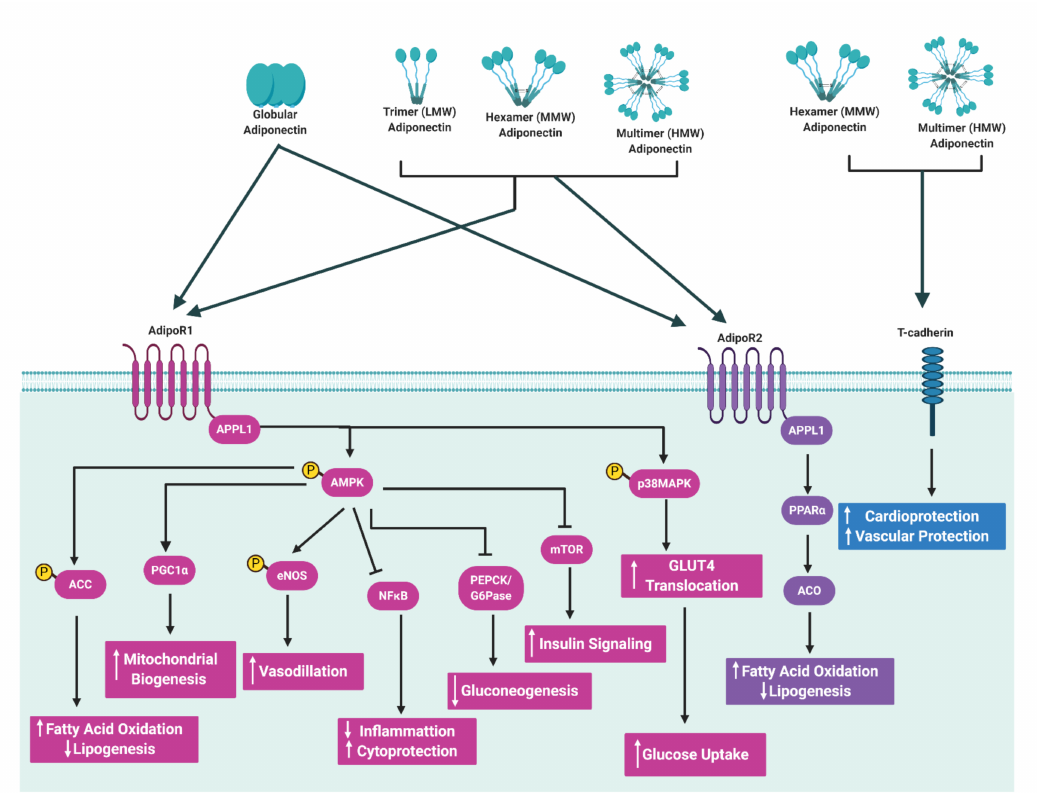
Figure 3. Schematic illustration of adiponectin intracellular signaling pathways. Adiponectin binds to its receptors (AdipoR1 and AdipoR2) and interacts with the adaptor protein containing a pleckstrin homology domain 1 (APPL1), leading to the activation of various signalling pathways including the 5 (cid:48) adenosine monophosphate-activated protein kinase (AMPK) and peroxisome proliferator-activated receptor alpha (PPAR α ) pathways. Activation of these pathways lead to cellular responses such as the suppression of glucose production, lipogenesis and inflammation, and the stimulation of glucose uptake, fatty acid oxidation, mitochondrial biogenesis and increased insulin sensitivity. Black arrowheads indicate activation and flat lines indicate inhibition. White arrows pointing upwards represent an increase, while arrows pointing downwards represent a decrease in cellular processes. Illustration created with BioRender.com. Abbreviations: ACC, acetyl CoA carboxylase; ACO, acyl CoA oxidase AdipoR1, adiponectin receptor 1; AdpoR2, adiponectin receptor 2; AMPK, 5 (cid:48) adenosine monophosphate- activated protein kinase; APPL1, adaptor protein containing a pleckstrin homology domain; eNOS, endothelial nitric oxide synthase, G6Pase, glucose 6-phosphatase; Glut4, glucose transporter 4; HMW, high molecular weight; LMW, low molecular weight; MMW, middle molecular weight; mTOR, mechanistic target of rapamycin; NF κ B, nuclear factor kappa-light-chain- enhancer of activated B cells; p38MAPK, mitogen activated protein kinase; PEPCK, phosphoenolpyruvate carboxykinase, PGC1 α , peroxisome proliferator activated receptor gamma coactivator 1 alpha; PPAR α , peroxisome proliferator activated receptor